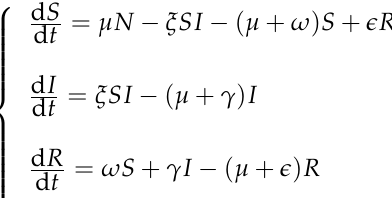
Table 1. Notation. N The number of all nodes in the WSN µ The proportion of birth and death sensor nodes ξ The proportion of susceptible nodes becoming infected nodes ω The proportion of susceptible nodes becoming recovered nodes γ The proportion of infected nodes becoming recovered nodes (cid:101) The proportion of recovered nodes becoming susceptible